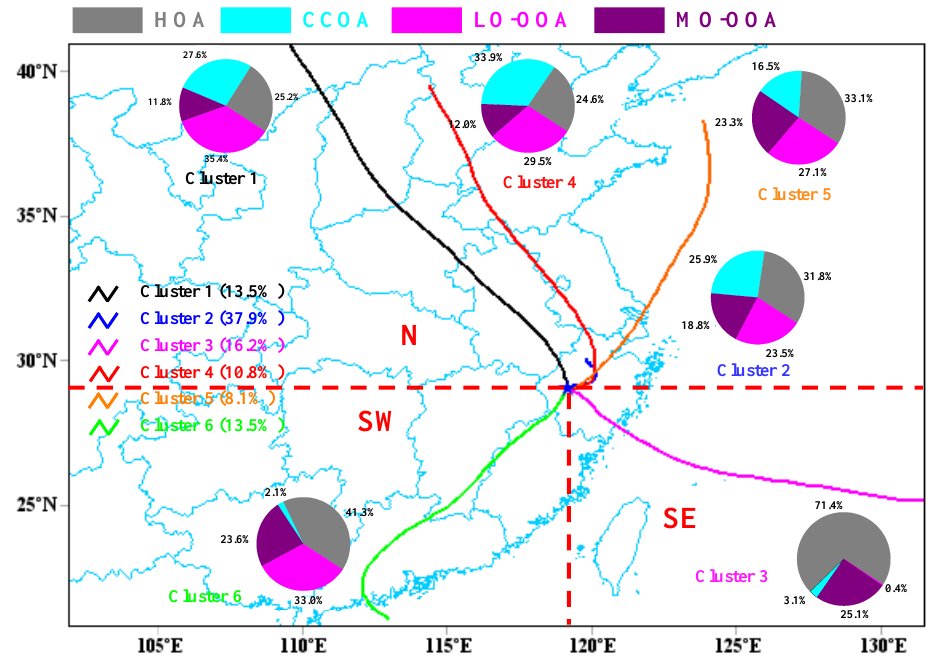
Figure 8. The simulation results of the cluster-mean trajectories during the sampling periods. The dashed lines divide the areas through which the air parcels passed.